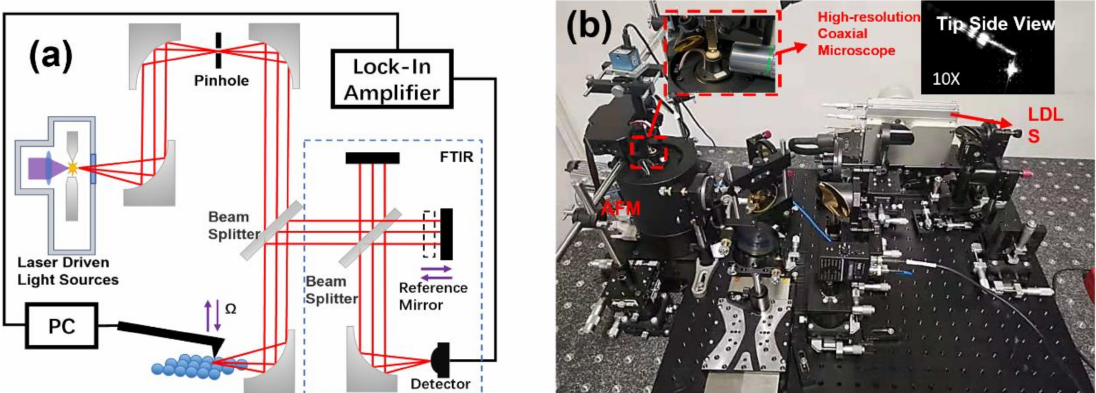
Figure 2. Home-built near-field spectroscopy and imaging set-up with a laser-driven light source. ( a ) Schematic of the set-up, and ( b ) physical image of our home-built